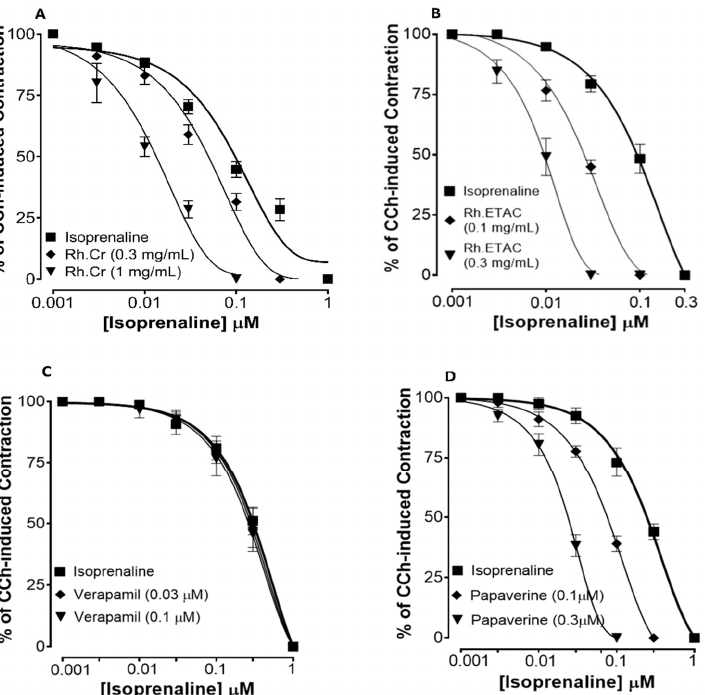
Figure 4. Concentration–response curves of isoprenaline against carbachol (CCh)-induced contrac- tions in the presence of different concentrations of ( A ) Rumex hastatas extract crude (Rh.Cr), ( B ) ethyl acetate fraction (Rh.ETAC) ( C ) verapamil and ( D ) papaverine in isolated rabbit jejunum preparations. Values are expressed as mean ± SEM ( n = 4–5).